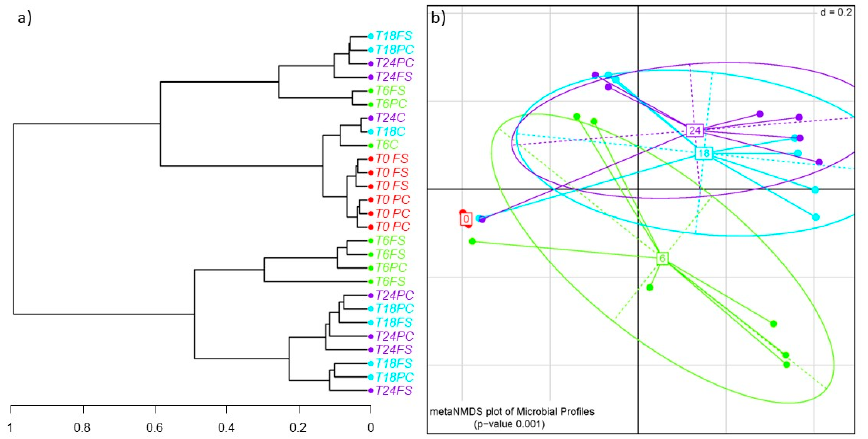
Figure 1. ( a ) Dendrogram and ( b ) generalized Unifrac NMDS plot of human gut microbiota batch cultures observed over 24 h (T0, T6, T18, T24 = observed timepoints 0 h (red), 6 h (green), 18 h (blue), and 24 h (purple); C = control fermentation without flaxseed, PC = digested flaxseed press cake, FS = digested milled whole flaxseed).